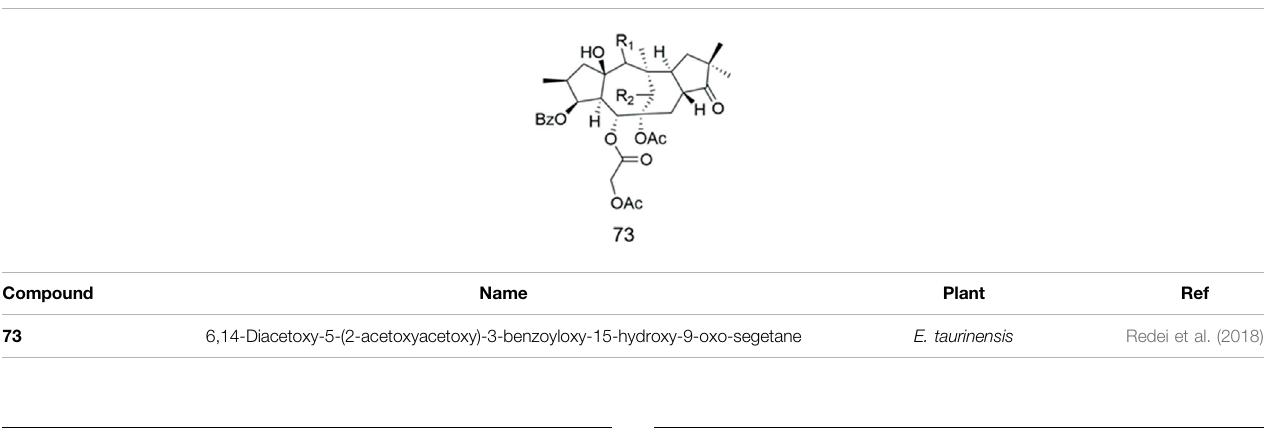
TABLE 6 | Segetanes.